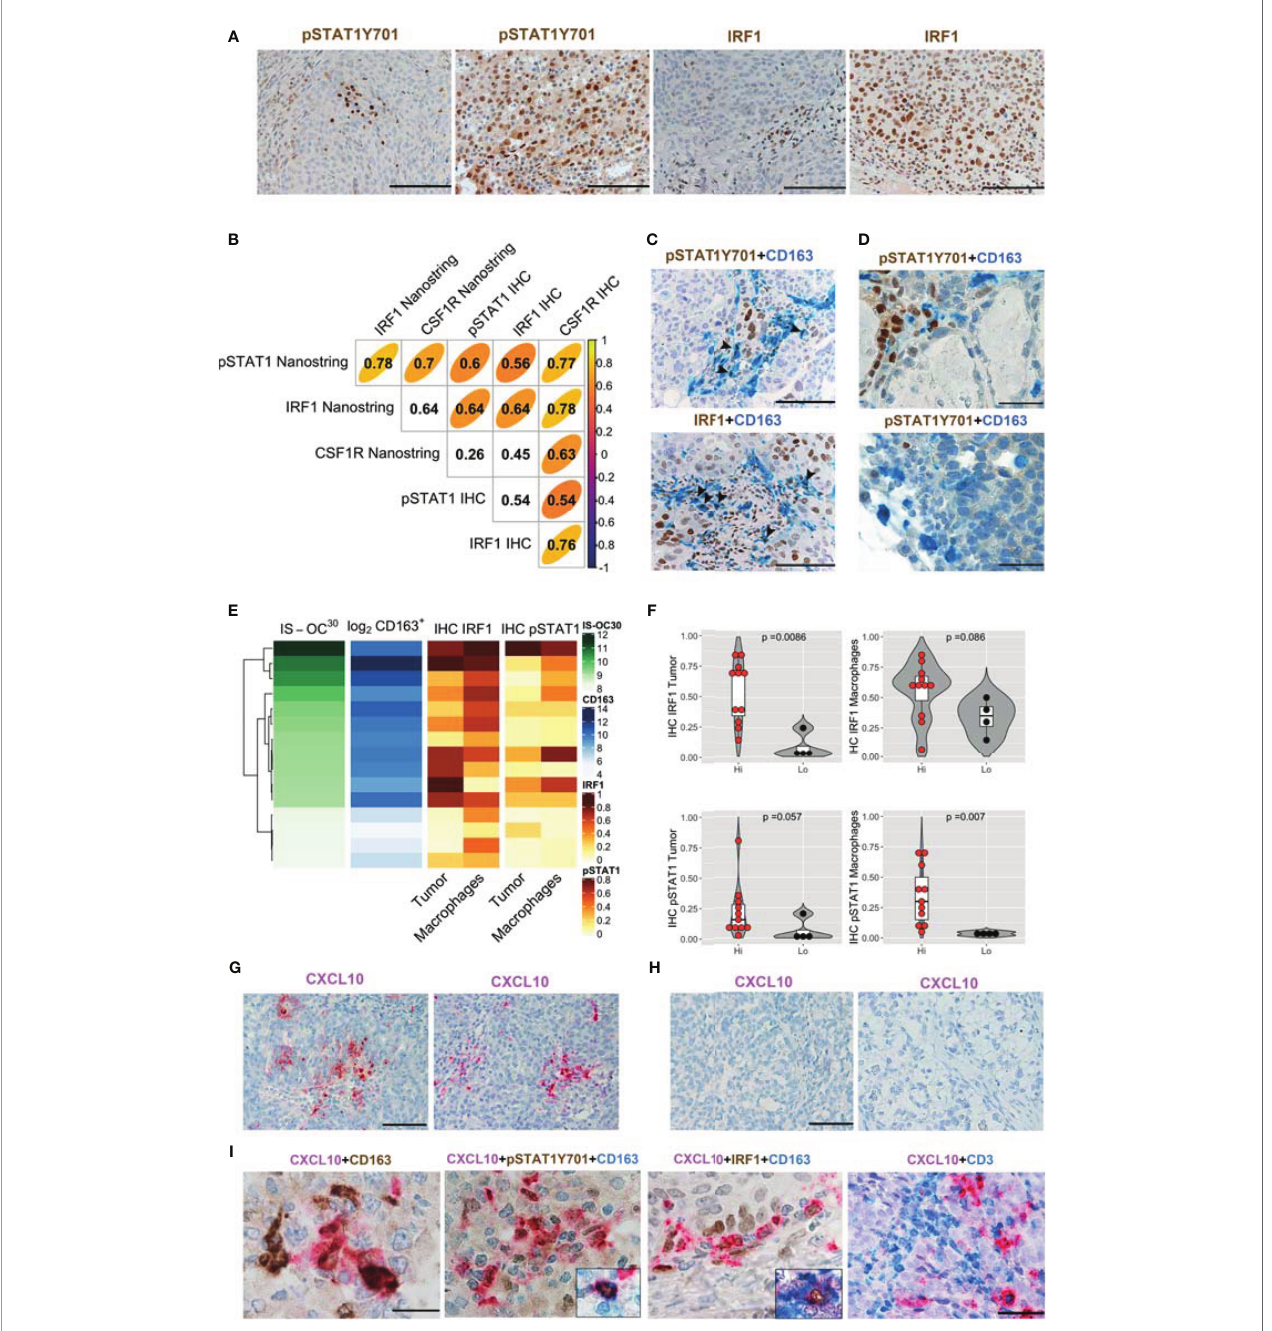
FIGURE 5 | IFN g polarization on cancer cells and stromal M1 type macrophages (M f ) in OCs. Sections from OCs cases and immunostained as labeled (A, C, D) . Magni fi cation 200× ( A, C ; scale bar 100 um); magni fi cation 400× ( D , scale bar 50 um). Different levels of pSTAT1Y701 and IRF1 expression in Lo OC-IS 30 CD163 L and Hi OC-IS 30 CD163 Hi HGSCs cases (A) . Spearman correlogram of IRF1, pSTAT1Y701 and CSF1R in OCs by IHC and Nanostring (B) . A fraction of HGSCs in fi ltrating CD163 + TAMs expresses pSTAT1Y701 and IRF1 (C) . Sections of CCCs showing that this tumor histotype is largely devoid of pSTAT1Y701 + TAMs (D) . Heatmap showing the IHC IRF1 and pSTAT1Y701 expression on different tissue compartments compared to the matched OC-IS 30 score and log 2 CD163 + density (E) ; Violin plots reporting the IHC IRF1 and pSTAT1Y701 expression in the Hi OC-IS 30 CD163 Hi and Lo OC-IS 30 CD163 Lo groups, p values estimated by Mann – Whitney test (F) . (G – I) Sections from OCs immunostained or subjected to in situ hybridization as labeled; while CXCL10 is detected in Hi OC-IS 30 CD163 Hi HGSCs (G) cases it is absent in a Lo OC-IS 30 CD163 Lo CCCs cases (H) . A fraction of CXCL10 + cells is con fi rmed to have a M1 M f identity and areas containing CXCL10 + macrophages are enriched of T-cells (I) . Magni fi cation: (G, H) 200× (scale bar 100 um) and (I) 600× (scale bar 33 um, fi rst three panels) and 400× (scale bar 50 um, right panel). (C, D) : arrowheads pointing double positive